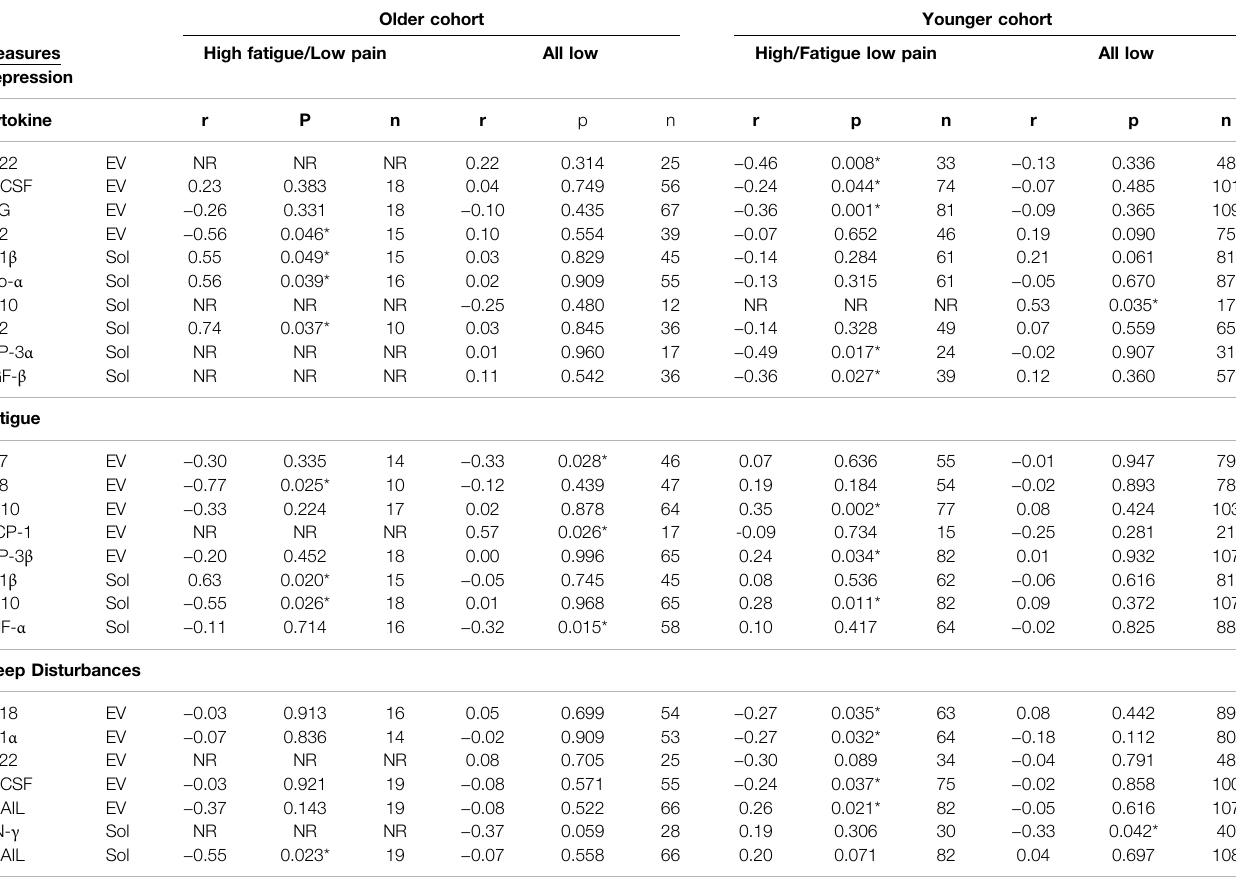
TABLE 3 | Signi fi cant correlations between cytokine concentrations and severity of depression, fatigue, and sleep disturbance strati fi ed by age cohorts and symptom classes. Older cohort Younger cohort Measures High fatigue/Low Depression